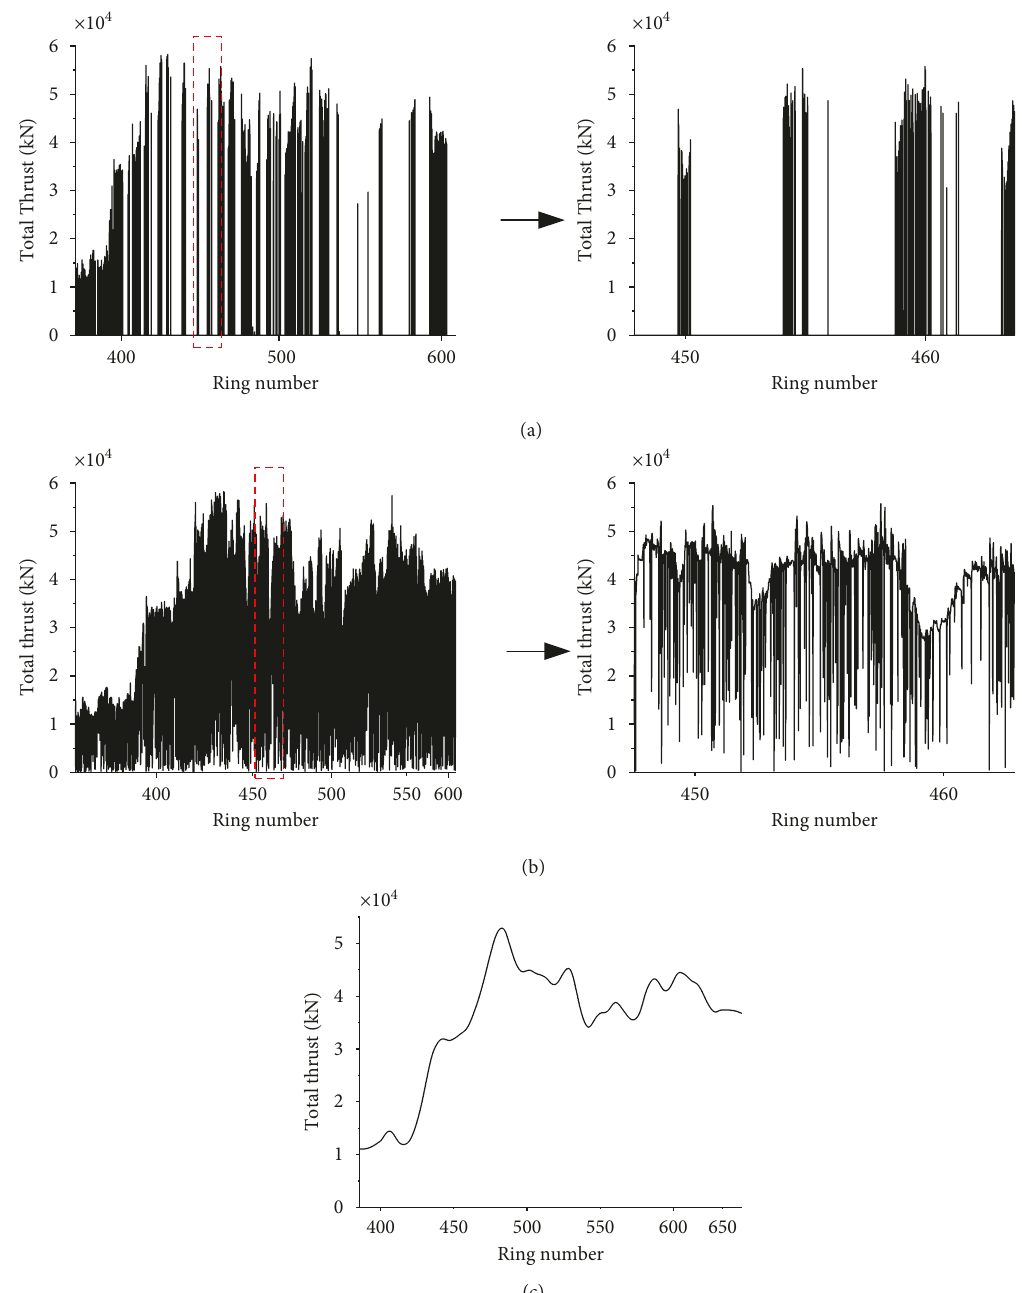
Figure 3: Comparison chart of total thrust before and after data processing: (a) original total thrust and partially enlarged view; (b) total thrust after binary discrimination and partially enlarged view; (c) total thrust after